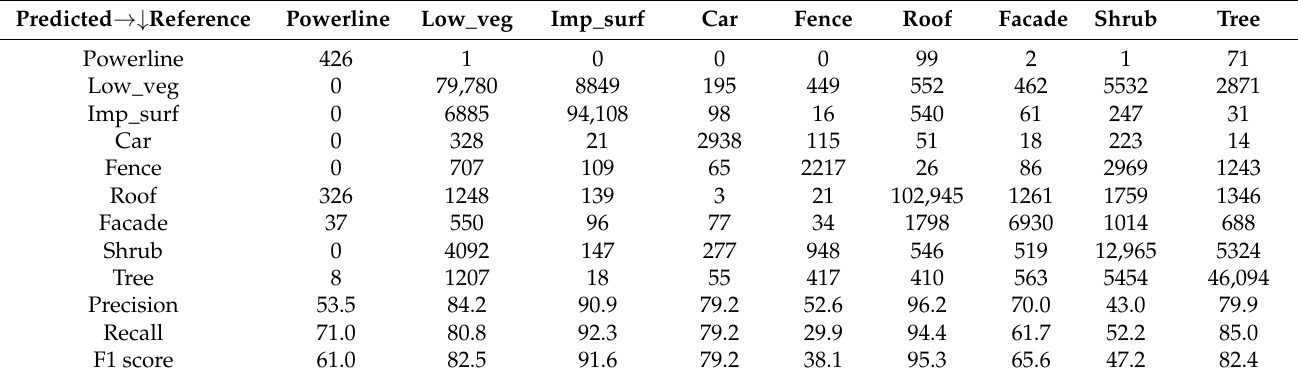
Table 4. The confusion matrix of our method on the Vaihingen 3D test set with per-class precision, recall and F1 score (%). Predicted →↓ Reference